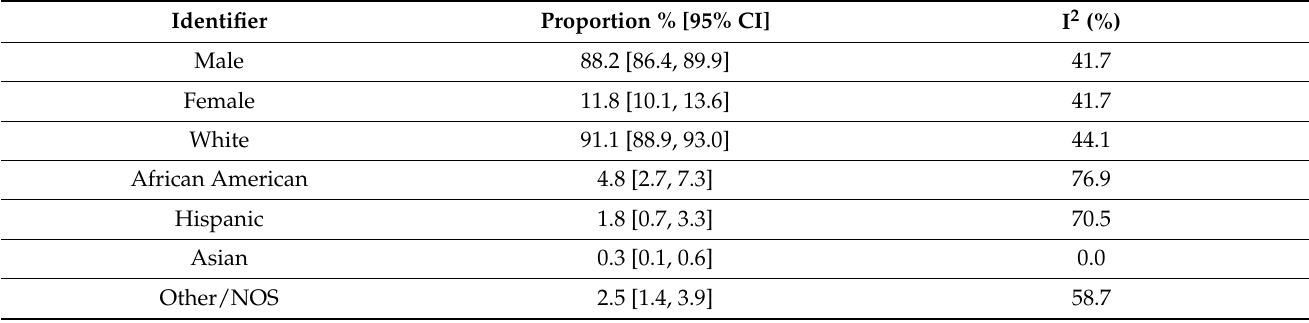
Figure 4. Funnel plot of all included studies. Table 2. Meta-analyses of patient sex and race and I 2 values amongst all studies and patients.